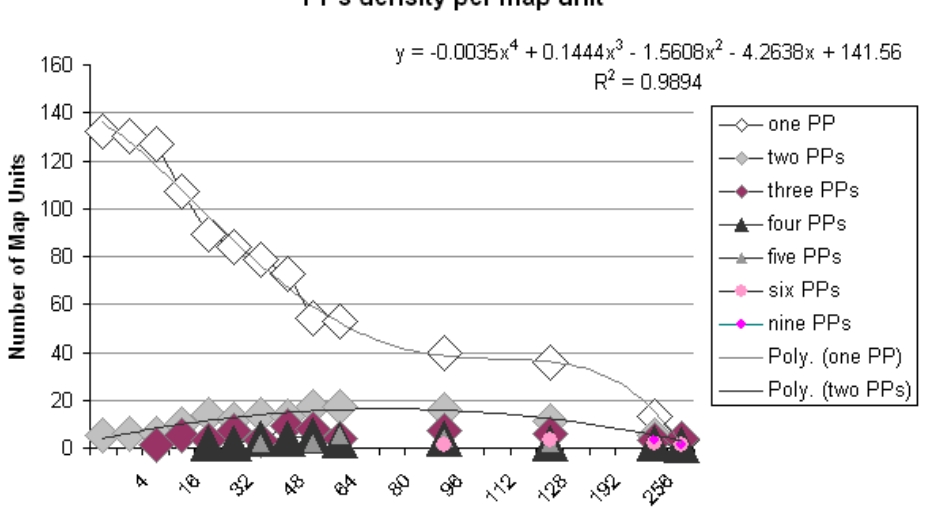
Figure 6. Parlance Points per map